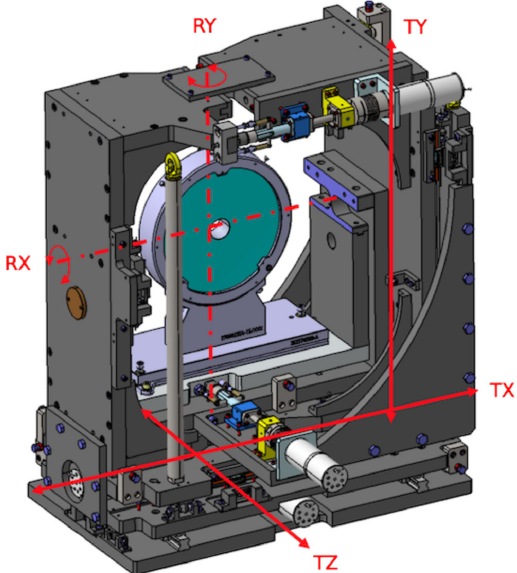
r FIG. 5. 3D view of the mechanical model of the five-axis motorized UHV compatible mount